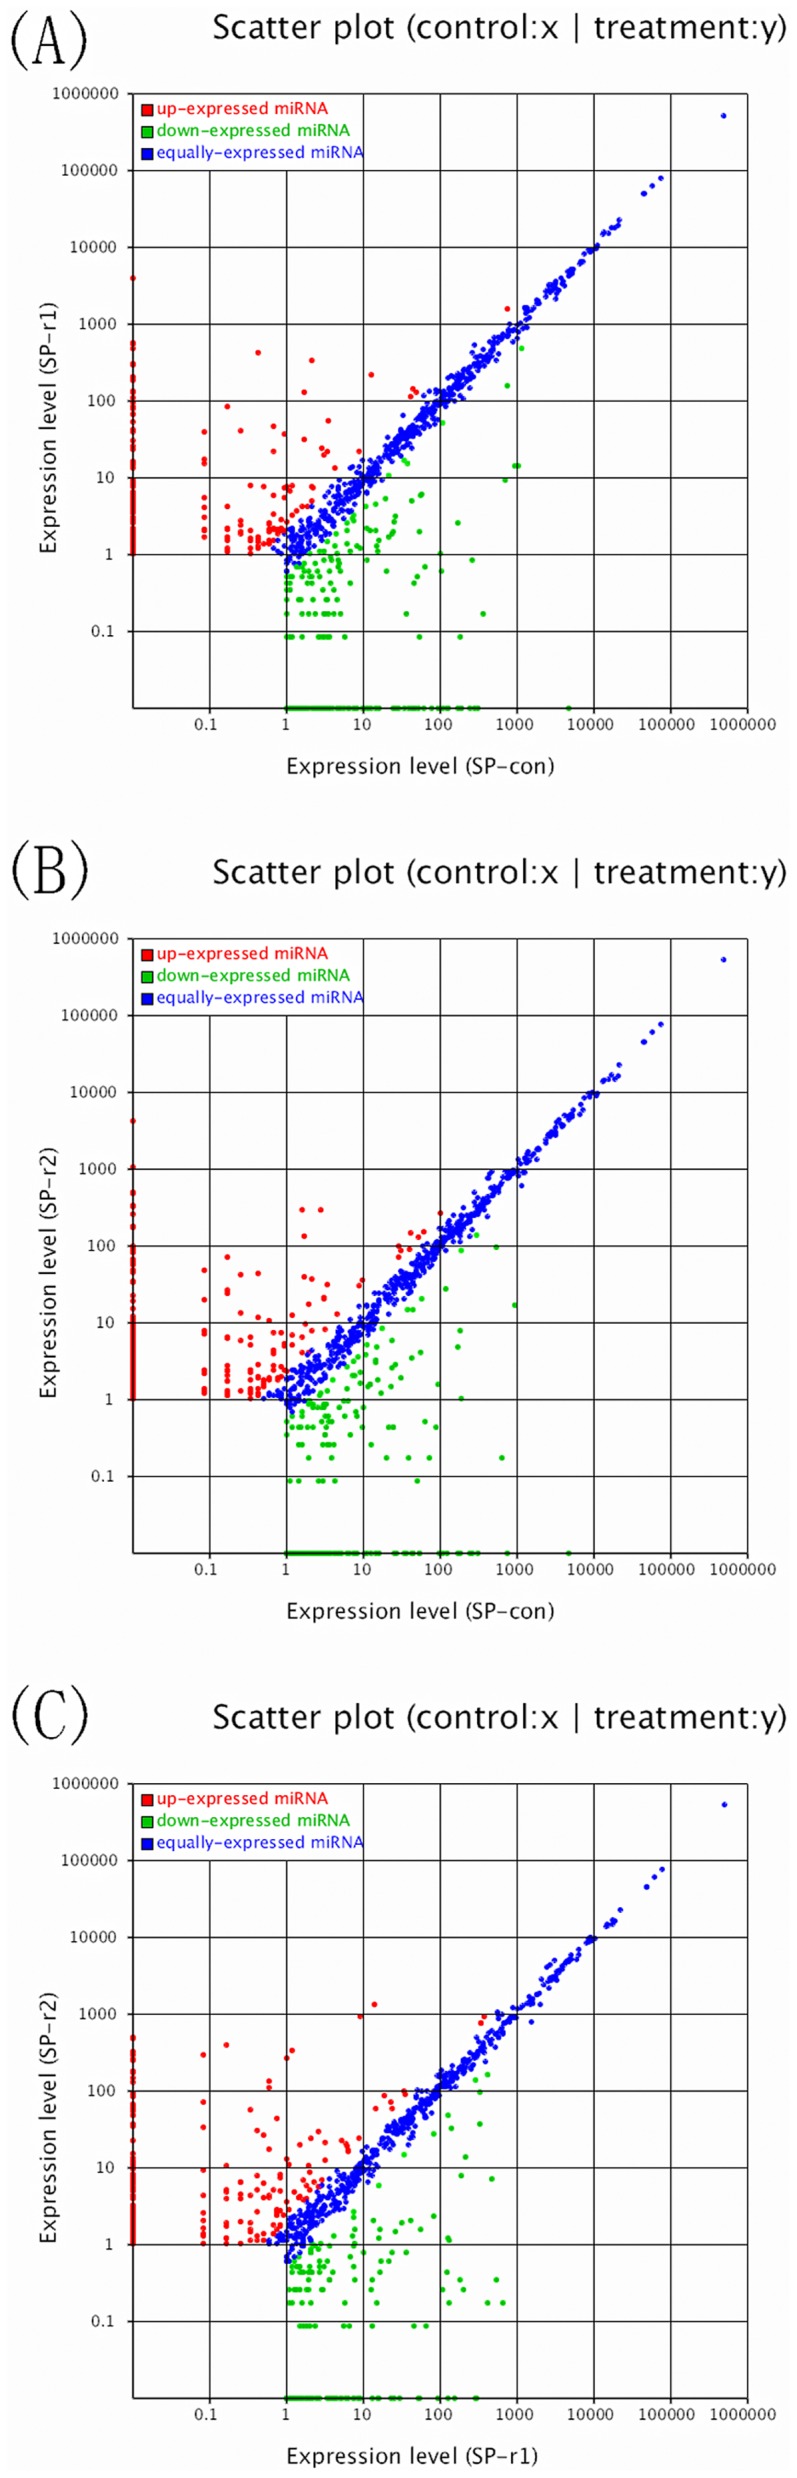
Log2-ratio scatter plot of the differentially expressed miRNAs between (A) the Sp-con and Sp-γ1 groups, (B) the Sp-con and Sp-γ2 groups, and (C) the Sp-γ1 and SP-γ2 groups.Each point in the figure represents a miRNA. The X and Y axes show the expression levels in the two samples. The red points represent miRNAs with a ratio >2, the blue points represent miRNAs with a ratio >1/2 and ≤2, and the green points represent miRNAs with a ratio ≤1/2.